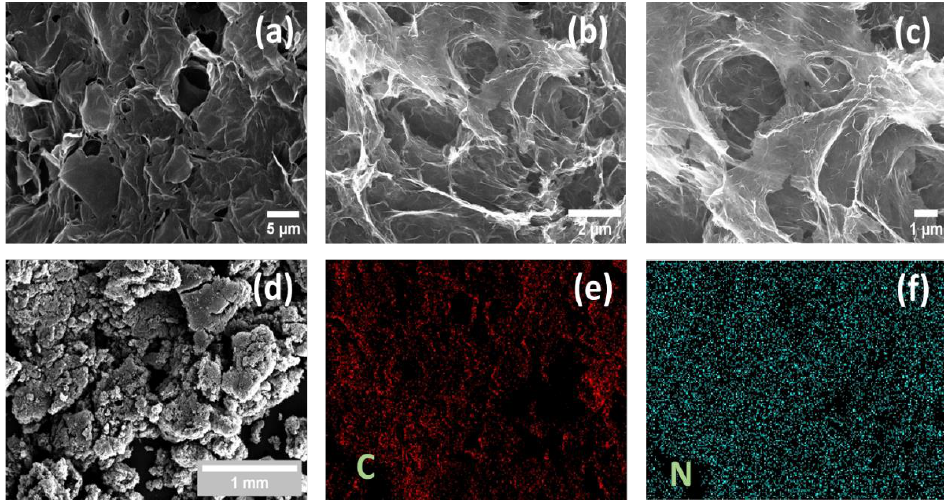
Figure 3. The images from FE-SEM analysis: ( a,d ) for GO; ( b,c ) for N-rGO-1 and N-rGO-2, respec- tively; the elemental mapping of ( e ) carbon and ( f ) nitrogen for N-rGOs.